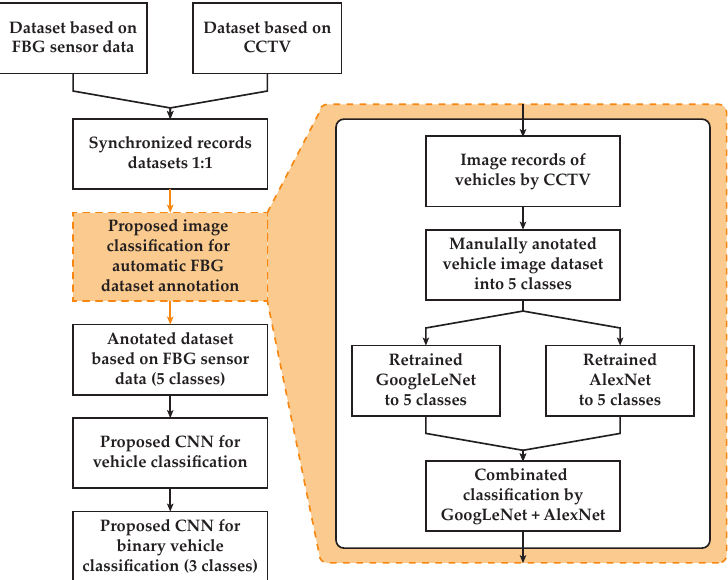
Figure 5. Block diagram of the proposed